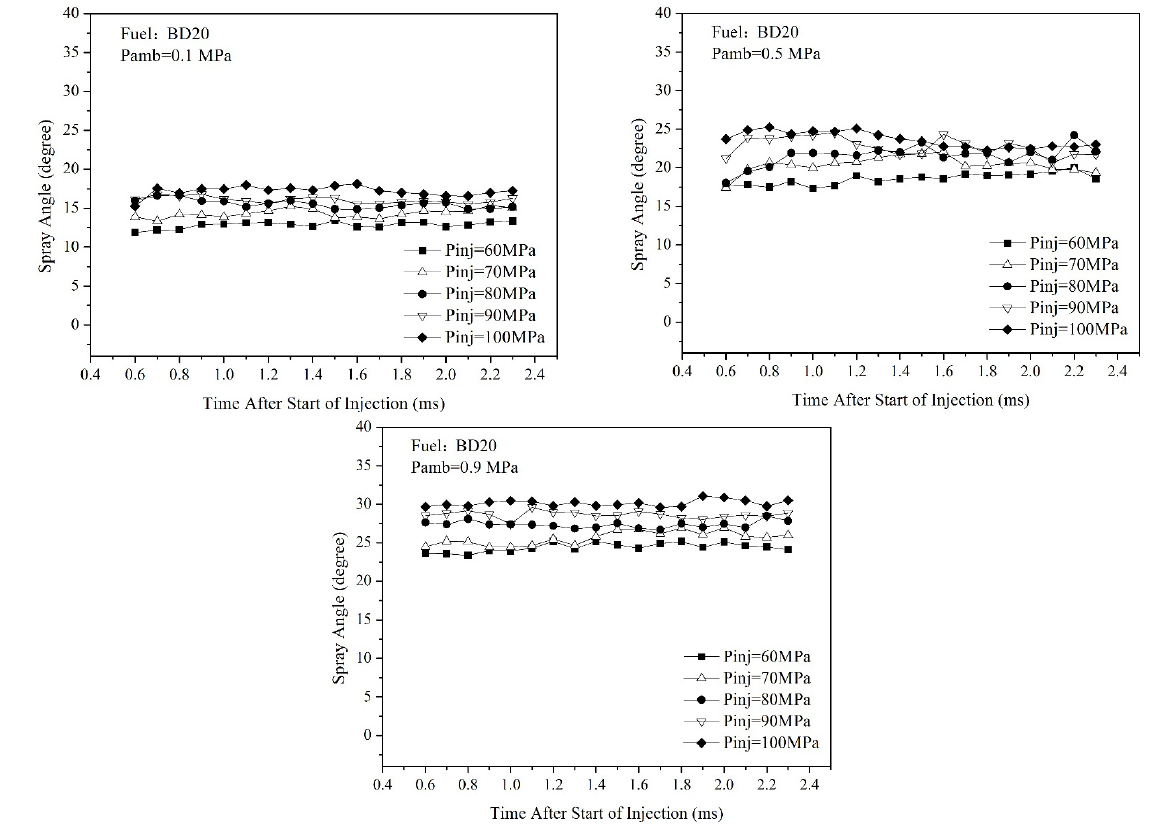
Figure 5. The spray angle for BD80 at different ambient